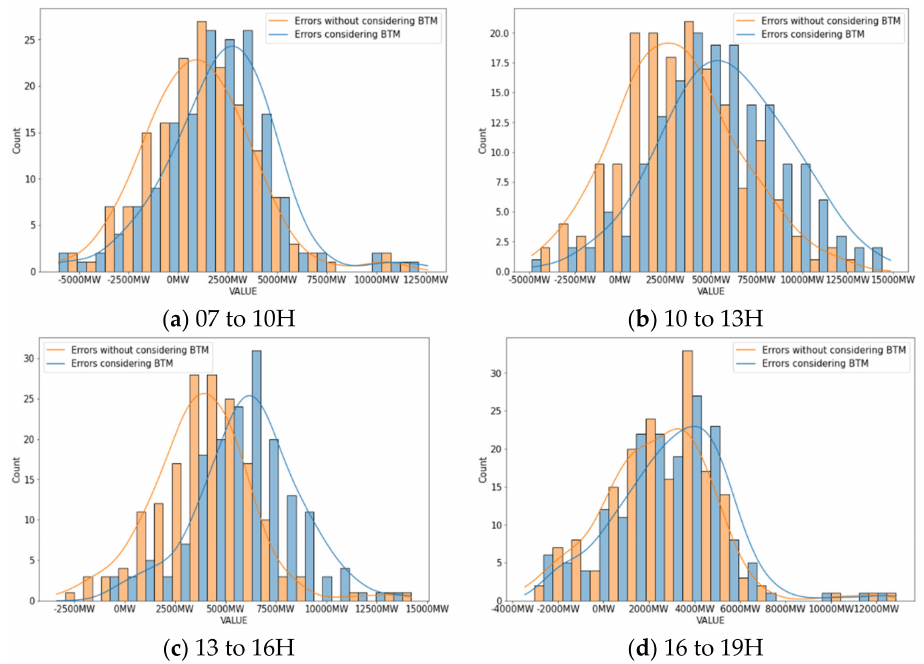
Figure 13. Detailed difference in the distribution of net load forecasting errors before and after reflecting BTM from May to July 2020. ( a ) shows the error distributions between 7 to 10H, ( b ) shows between 10 to 13H, ( c ) shows between 13 to 16H, and ( d ) shows between 16H to 19H. Table 5. Shapiro-Wilk Test results on net load forecasting errors after BTM capacity estimation from